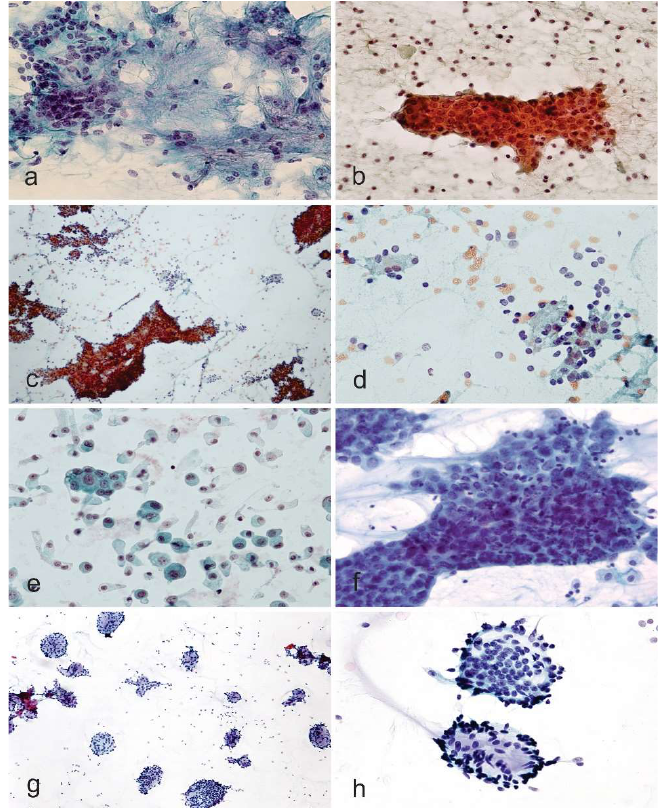
Figure 2. ( a , b ) Pleomorphic adenoma and Warthin tumor (Papanicolaou stain, ×100 and ×100, a and b , respectively). ( c , d ) Acinic cell carcinoma (Papanicolaou stain, ×40 and ×100, c and d , respectively). ( e , f ) Mucoepidermoid carcinoma (Papanicolaou stain, ×400 and Papanicolaou stain, ×400, e and f , respectively). The mucin in the background and the nuclear detail are supportive of a diagnosis of mucoepidermoid carcinoma. ( g , h ) Adenoid cystic carcinoma (Diff-Quik, ×100 and ×100, g and h , respectively). For the details of the single salivary gland tumors, please refer to the text.